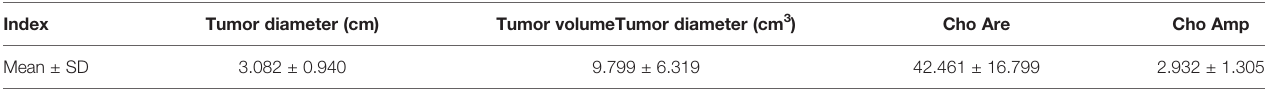
TABLE 1 | The mean values and standard deviations of tumor diameter, tumor volume, Cho Are, and Cho Amp in VX2 liver cancer (mean ± SD, n = 18).